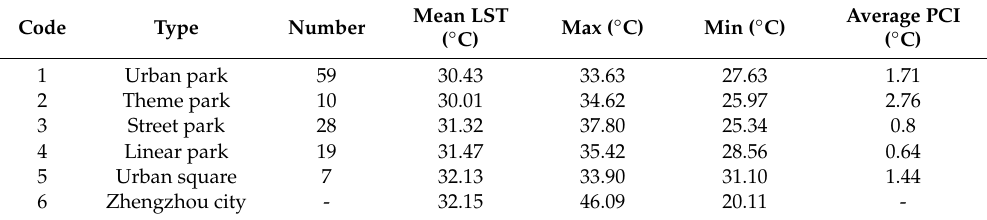
Table 5. Statistics of LST and average PCI in different park types.